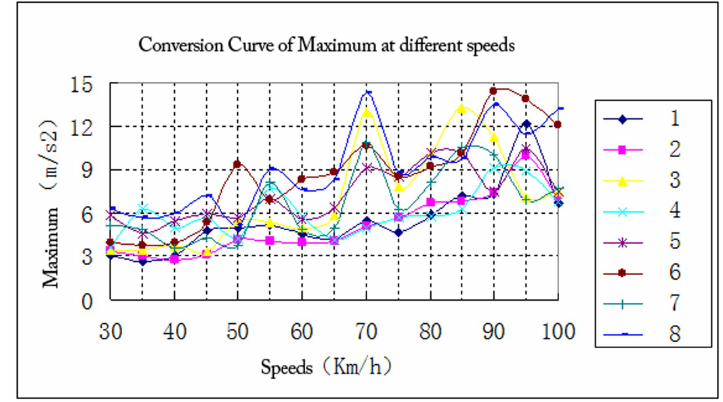
Fig. 7 Conversion curve of maximum at different speeds.